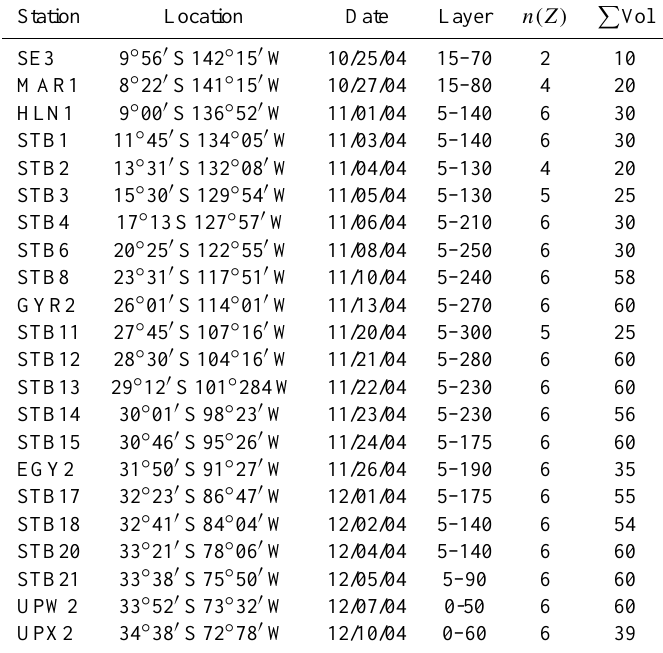
Table 1. Station locations and tintinnid sampling. Cruise track shown in Fig. 1. Layer denotes depth layer sampled in meters, n(Z) the number of discrete depth sampled within the layer and P Vol the total volume (l) screened through a 20 µ m mesh plankton